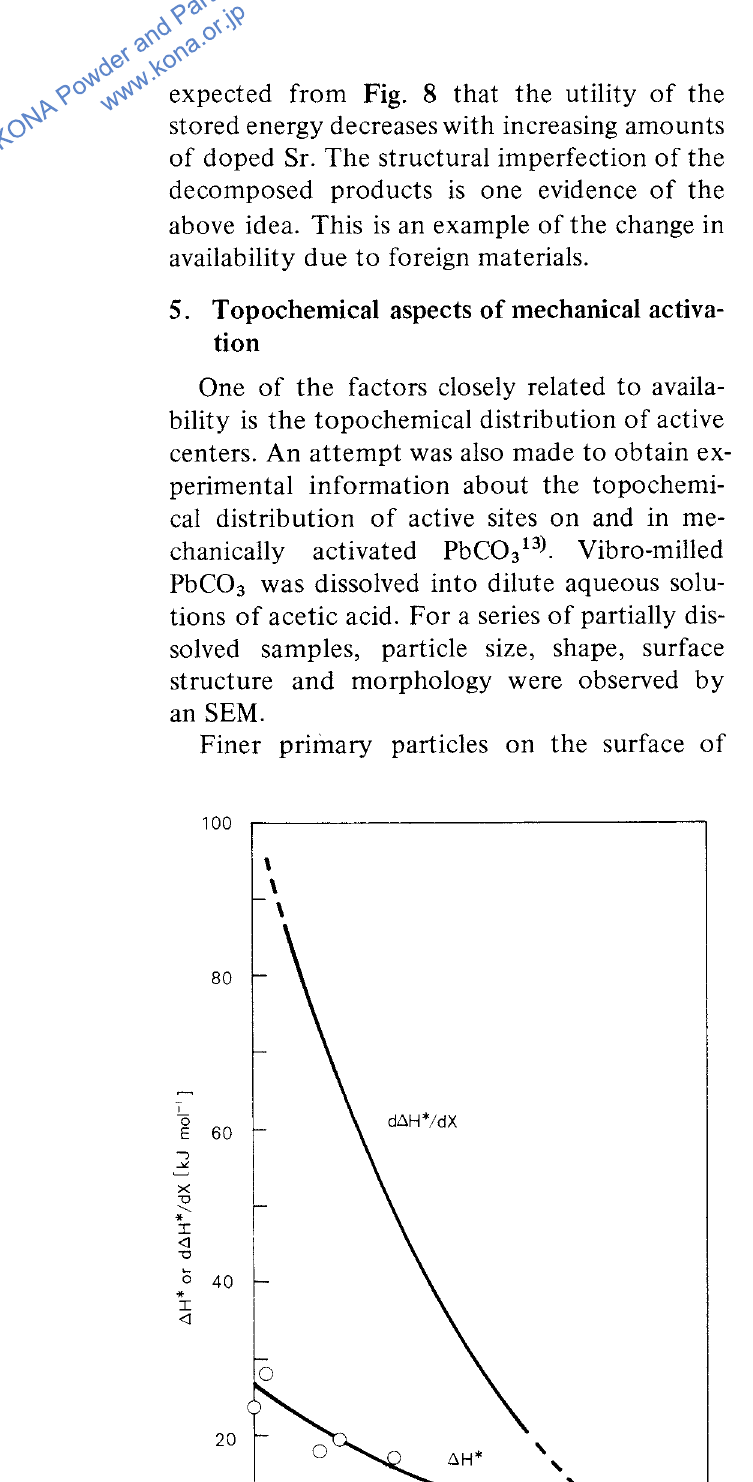
Fig. 9 Change in the excess enthalpy, M* and M* jdX with X, for mechanically activated lead